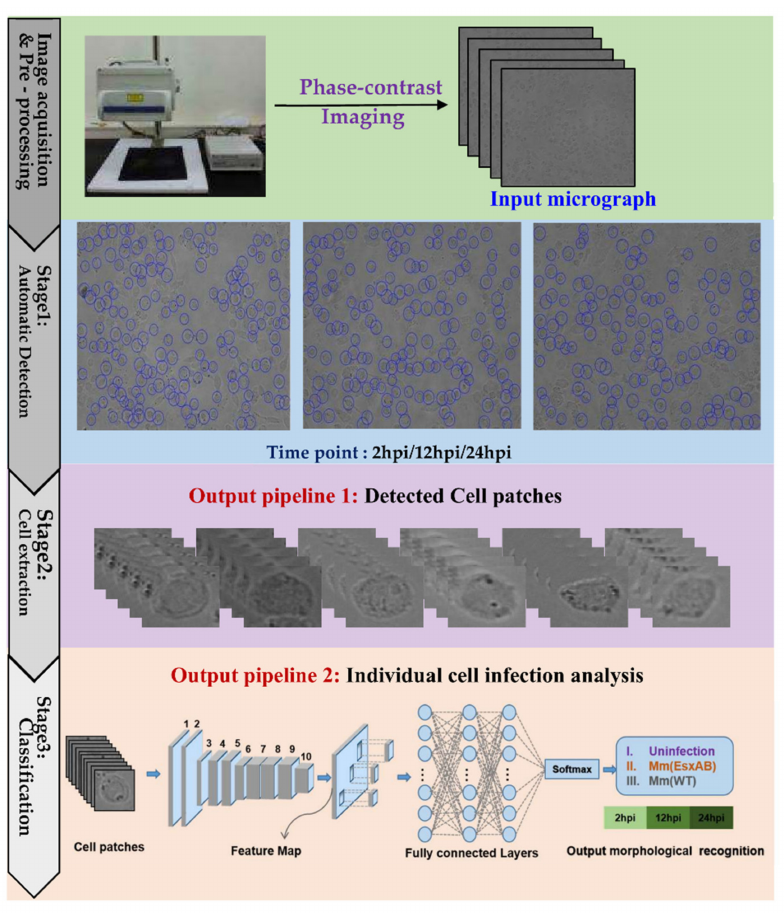
Figure 1. Overview of the proposed AutoCellANLS for infection analysis of different cell